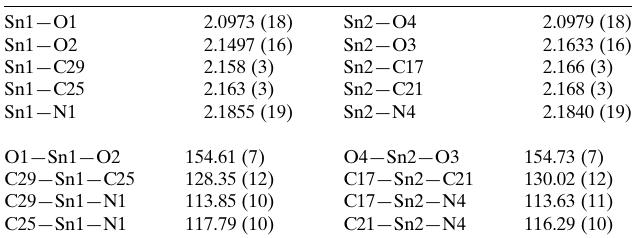
Table 1 Selected geometric parameters (A˚ , (cid:3)